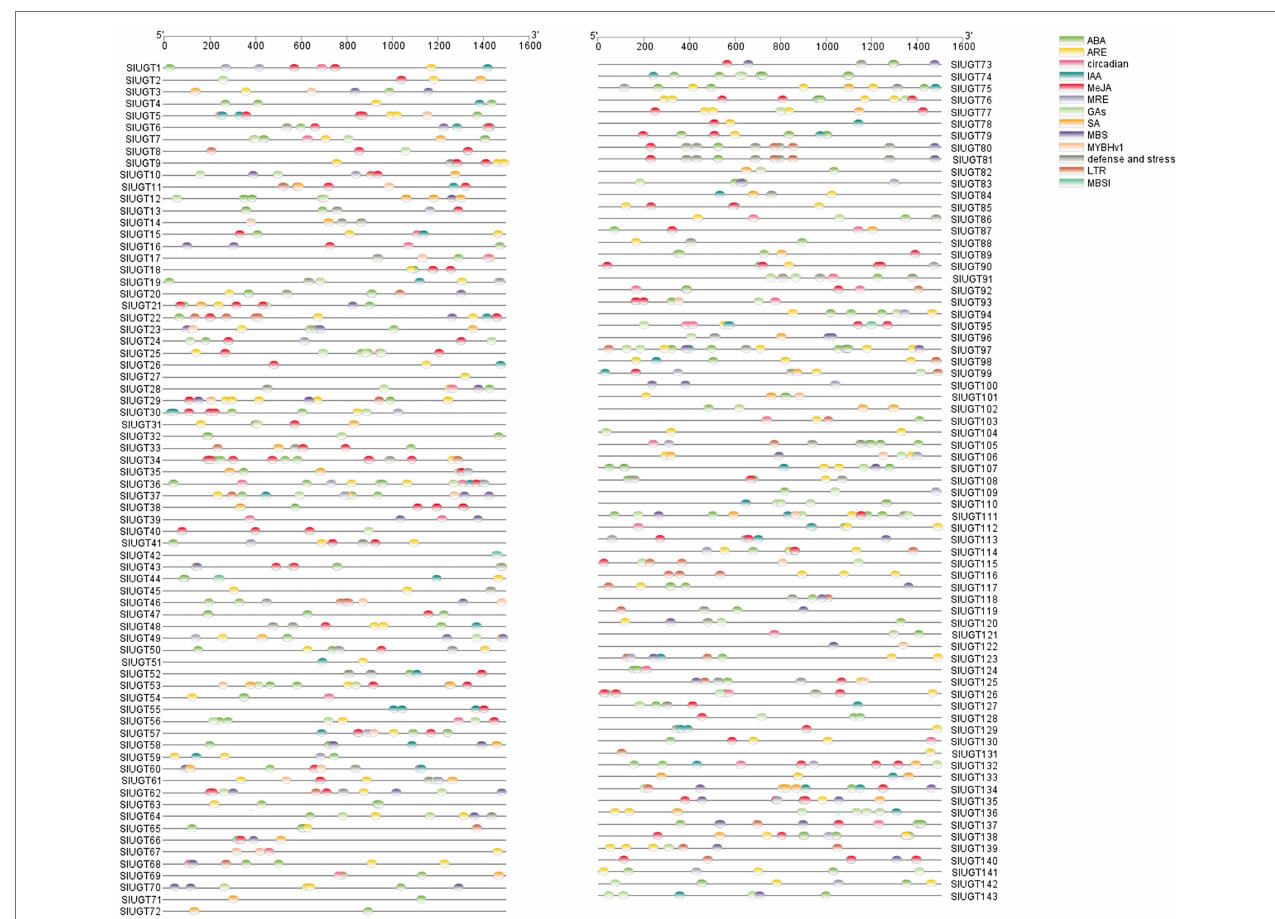
FIGURE 7 | Analysis of the cis-acting elements in SlUGT genes. Different colors represented different cis-acting elements and their position in the SlUGT